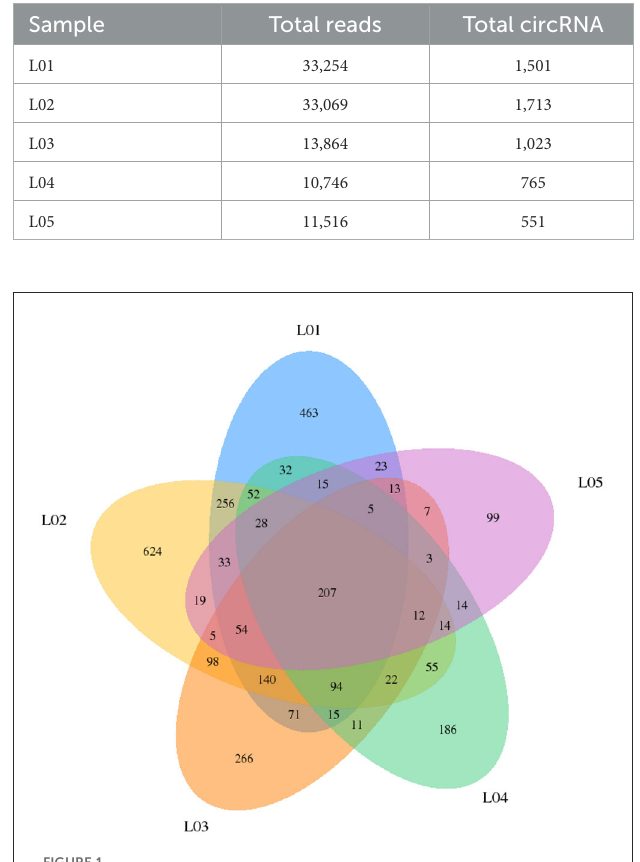
FIGURE1 Statistical diagram of circRNA species and number expressed in each